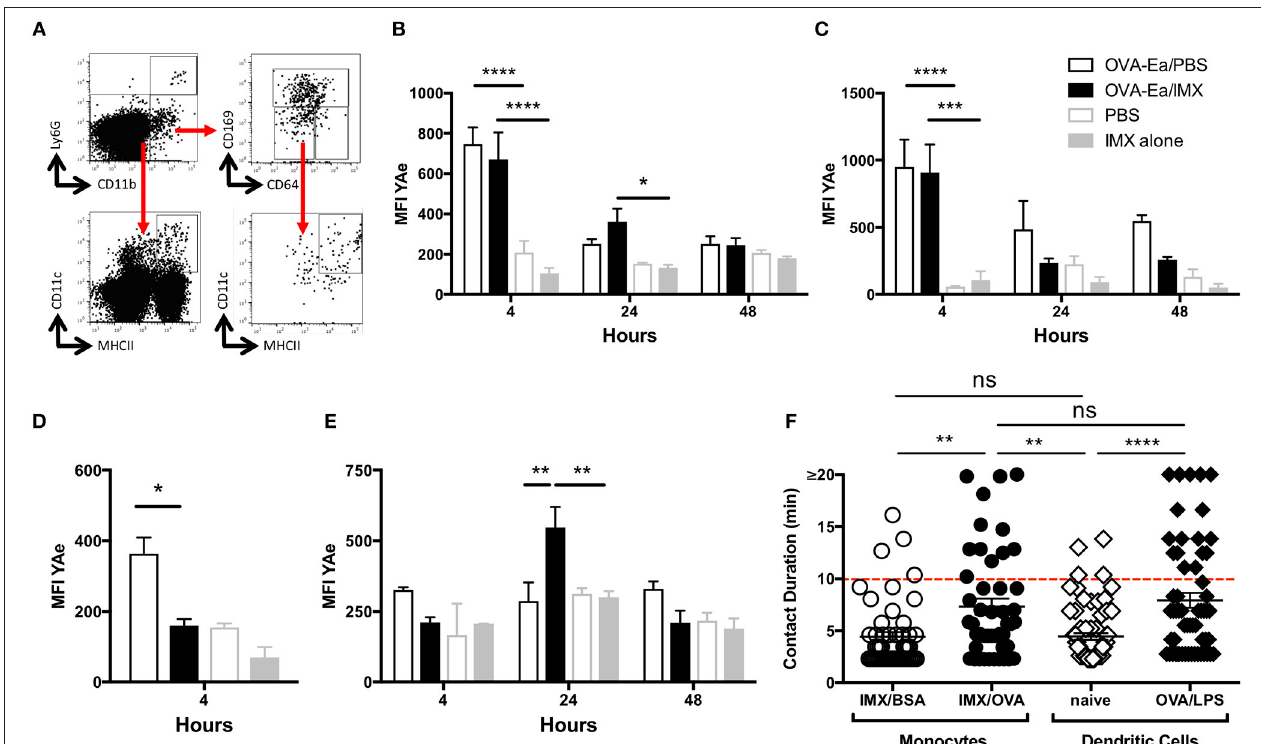
FIGURE 6 | Recruited monocytes present antigen and may be observed interacting with T cells in the lymph node at 24h post-immunization. (A) Representative plots showing flow cytometry gating strategy for the identification of CD11b + CD64 + monocytes, for CD11b + CD169 + SCS macrophages and CD11b- or CD11b + CD11c + MHCII + dendritic cells. Graphs showing mean ( ± SEM) YAe MFI on CD11b- (B) and CD11b + (C) dendritic cells at 4, 24, and 48h; mean ( ± SEM) YAe MFI SCS macrophages (D) at 4h; mean ( ± SEM) YAe MFI on monocytes (E) at 4, 24, and 48h. Groups contained 3 animals and data is representative of three independent experiments. (F) LysM-EGFP or CD11cYFP mice were immunized in the footpad (OVA or BSA/ISCOMATRIX or OVA/LPS respectively) ∼ 20h later the draining popliteal lymph node was surgically exposed. OTII DSRed T cells and monocytes (GFP + ) or DCs (YFP + ) were imaged by live real time multiphoton microscopy. Interaction between T cells and monocytes (and T cells and DCs was identified by colocalization of the DSRed signal with the GFP or YFP signals and tracked for up to 20min, 48 such interactions were tracked in the OVA/ISCOMATRIX treated mice. IMX = ISCOMATRIX TM adjuvant, * P < 0.05, ** P < 0.01, *** P < 0.001 **** P <